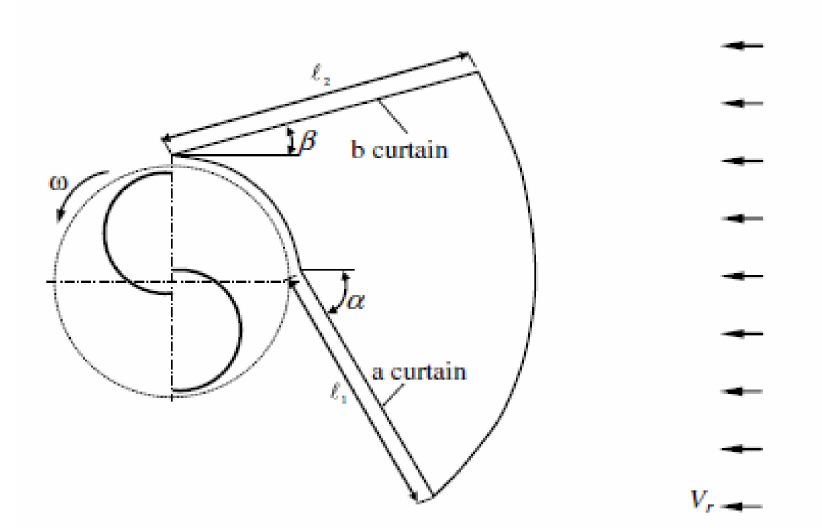
Figure 15. The SAVONIUS rotor model with a curtain [86].